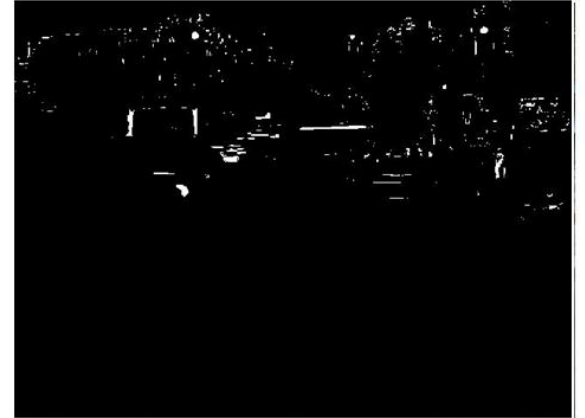
Fig. 2. Result image of color thresholding on the source